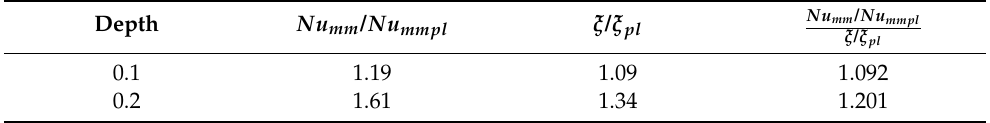
Table 3. Comparison of the heat transfer, hydraulic losses, and thermal-hydraulic efficiency of a channel section with two trench